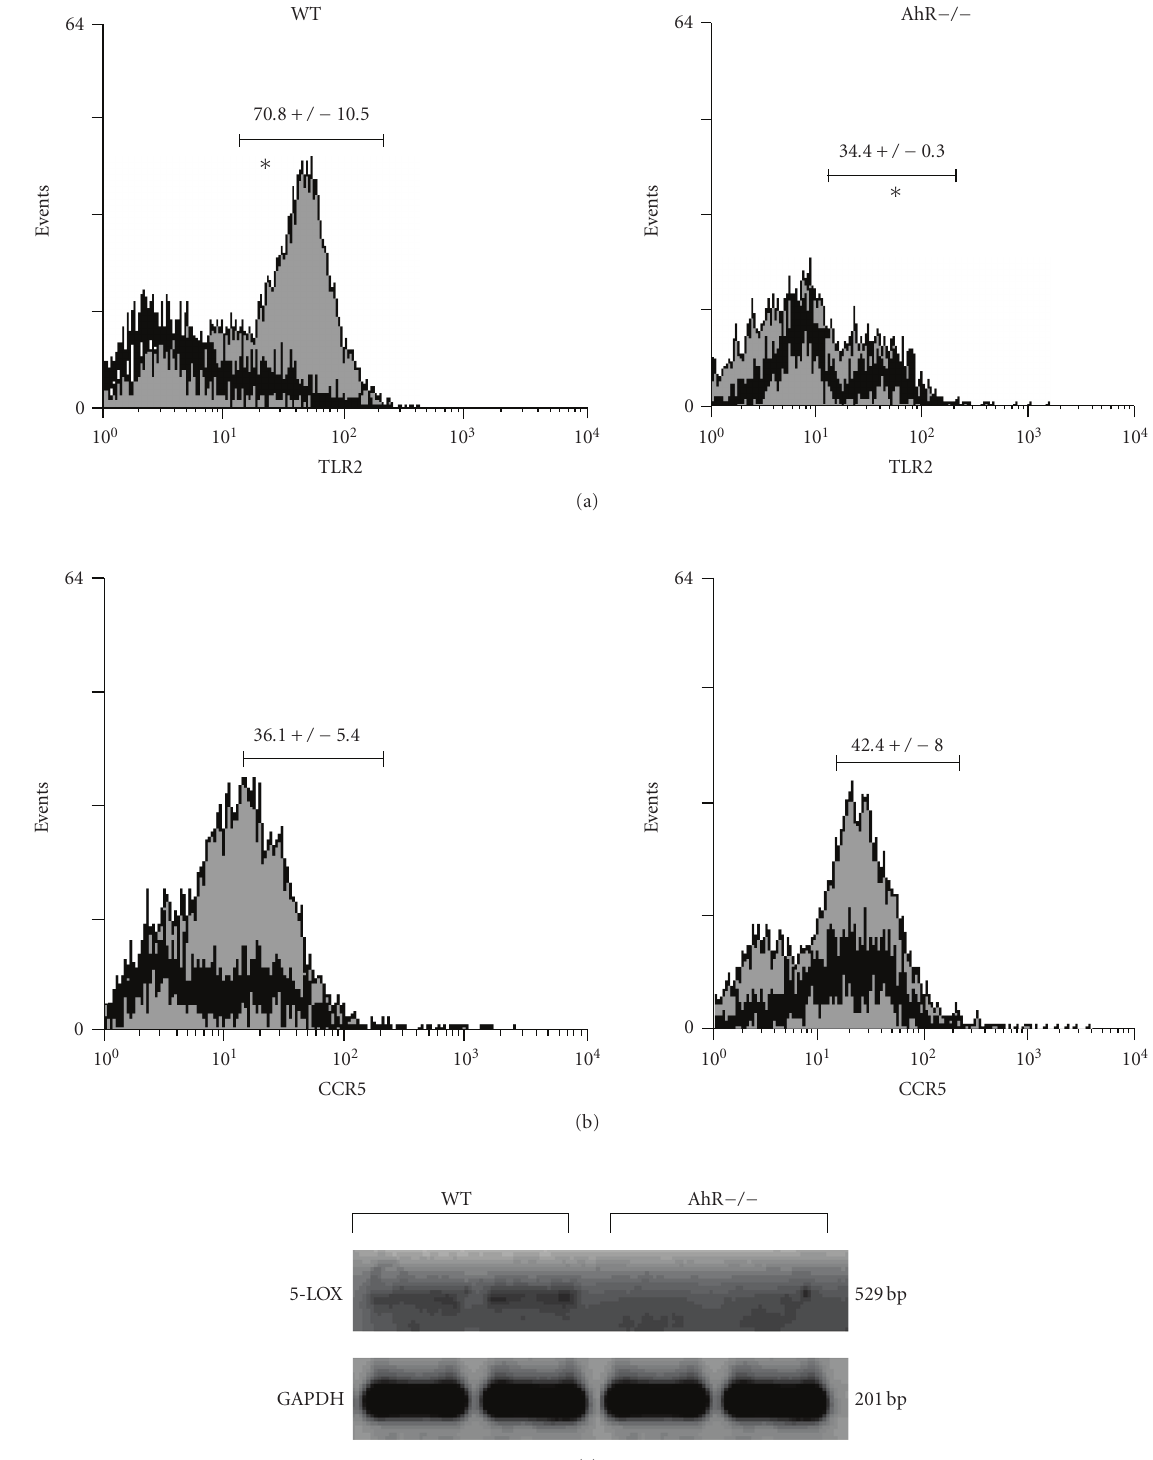
Figure 8: Flow cytometric profiles of adherent exudate macrophages stained for TLR2 and CCR5. The histograms represent TLR2 (a) or CCR5 (b) versus F4/80 expression on adherent macrophages from AhR-/- or WT mice challenged with STAg for 24 hours after 25 days of T. gondii infection: Nonstimulus (dark line) and STAg stimulus (gray curve). Shown are representative data from three to four independent experiments. Significances were calculated by Student’s t test. ∗ P < . 05 WT versus AhR-/-. Gel electrophoresis of 5-LOX and GAPDH- amplified products (c). Total RNA was isolated from splenocytes from WT and AhR-/- mice at 25 days after T. gondii infection as described in Materials and Methods